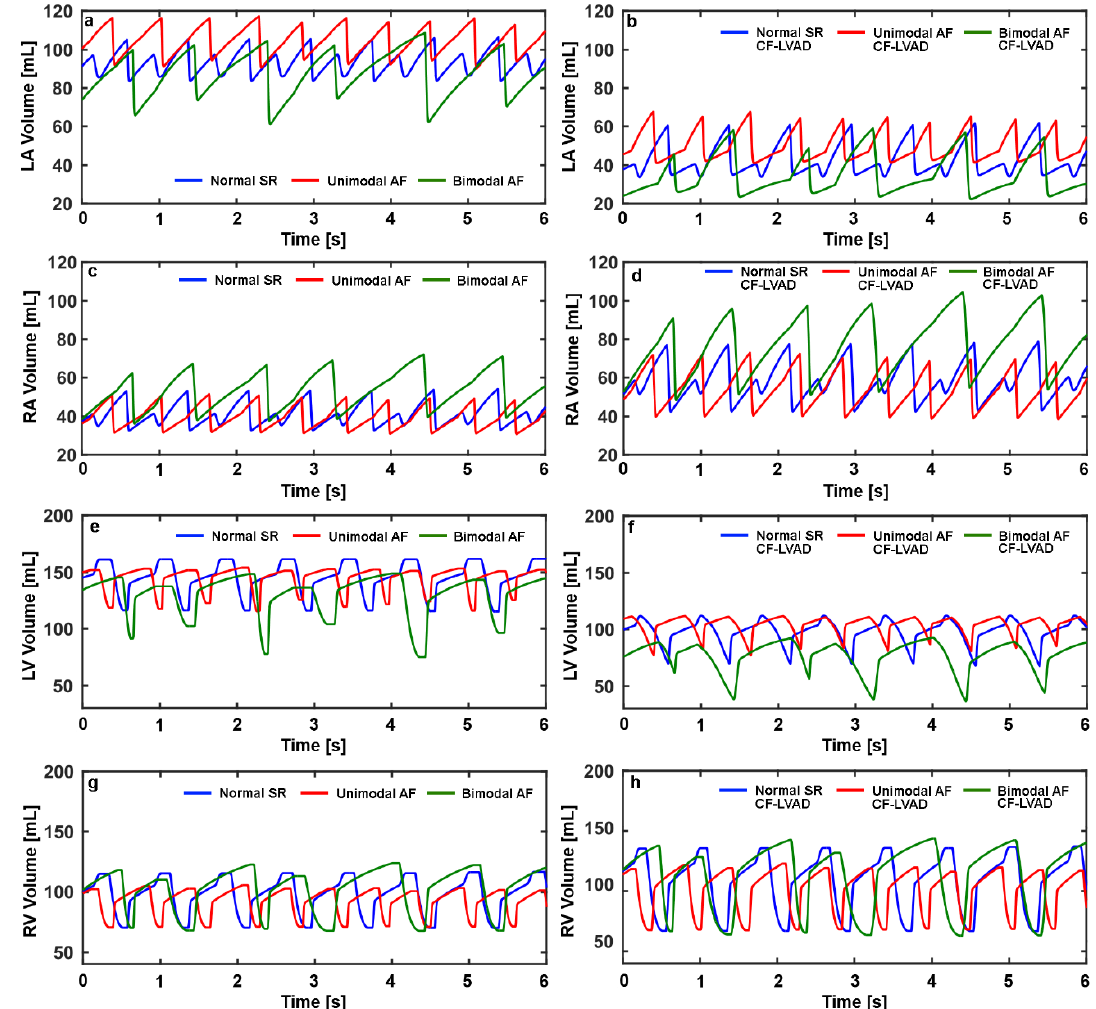
Figure 3. ( a ) Left atrial (LA) volumes for heart failure during normal sinus rhythm (SR) and atrial fibrillation (AF) with unimodal and bimodal RR interval distributions; ( b ) LA volumes for CF-LVAD support during normal SR and AF with unimodal and bimodal RR interval distributions; ( c ) right atrial (RA) volumes for heart failure during normal SR and AF with unimodal and bimodal RR interval distributions; ( d ) RA volumes for CF-LVAD support during normal SR and AF with unimodal and bimodal RR interval distributions; ( e ) left ventricular (LV) volumes for heart failure during normal SR and AF with unimodal and bimodal RR interval distributions; ( f ) LV volumes for CF-LVAD support during normal SR and AF with unimodal and bimodal RR interval distributions; ( g ) right ventricular (RV) volumes for heart failure during normal SR and AF with unimodal and bimodal RR interval distributions; ( h ) RV volumes for CF-LVAD support during normal SR and AF with unimodal and bimodal RR interval distributions.